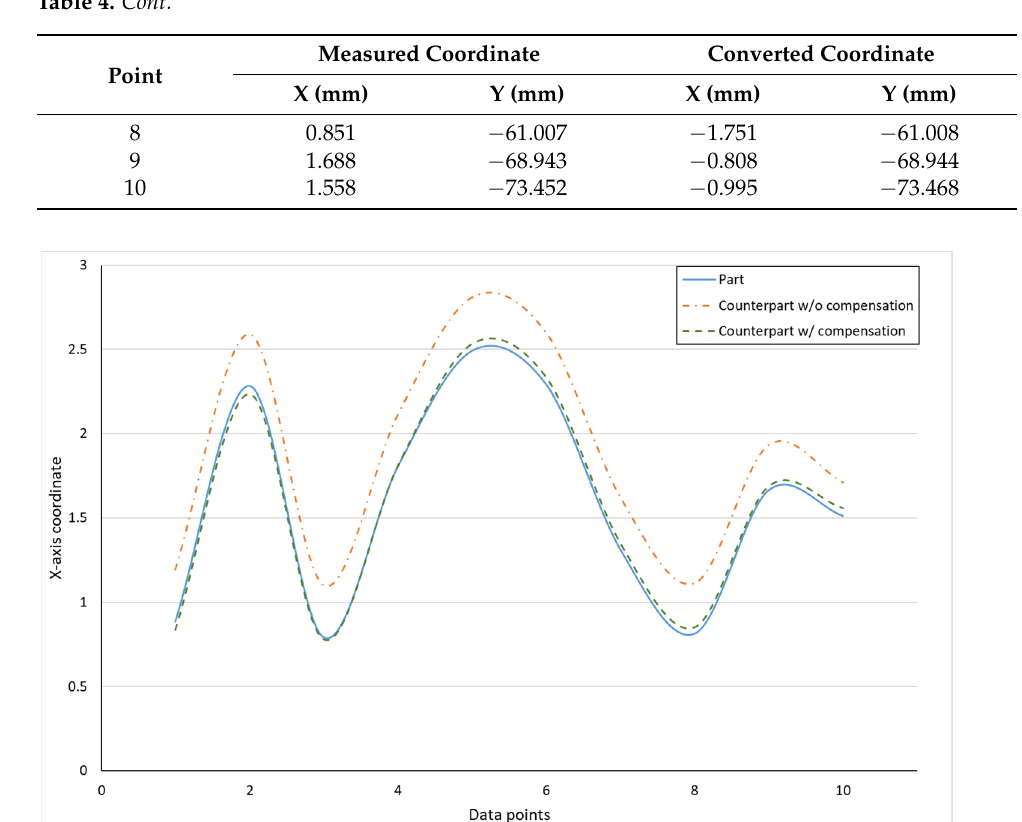
Figure 13. Error comparison between counterpart w/o and w/ compensation for curve mating.